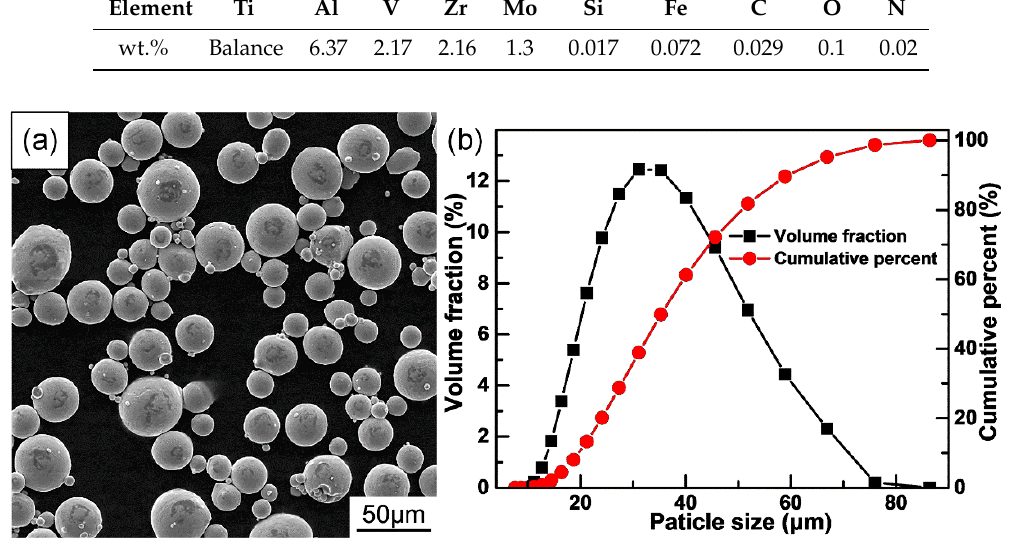
Figure 2. ( a ) Morphology and ( b ) particle size distribution of TA15 powder.